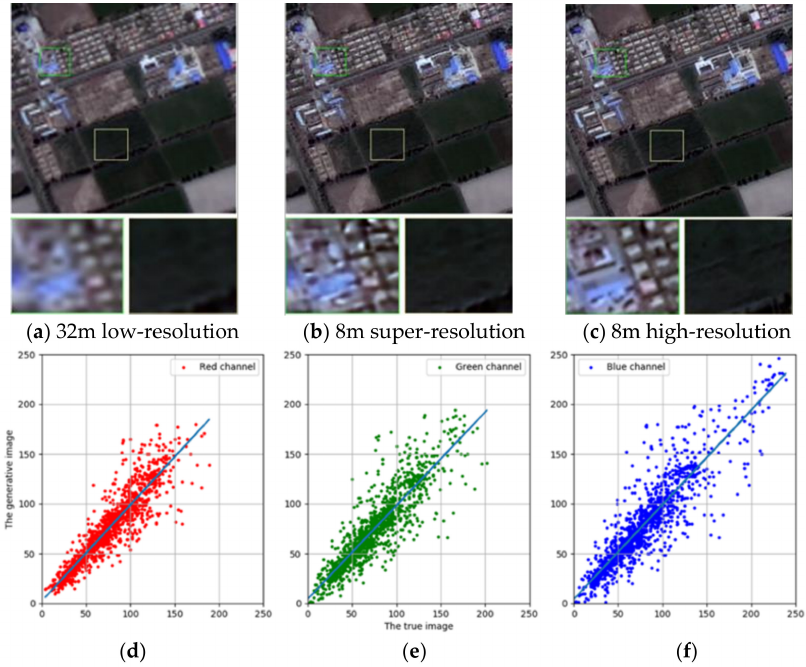
Figure 5. Cross-location comparison: the predicted super-resolution image for our ISRGAN model ( b ) on a GF 1 dataset in Xinjiang, compared to the input image ( a ) and the ground truth ( c ). Figures ( d ), ( e ), and ( f ) are 1:1 plots of the DN value in the red, green and blue bands compared to the ground truth ( c ), with slopes of 0.9658, 0.9378 and 0.9485,